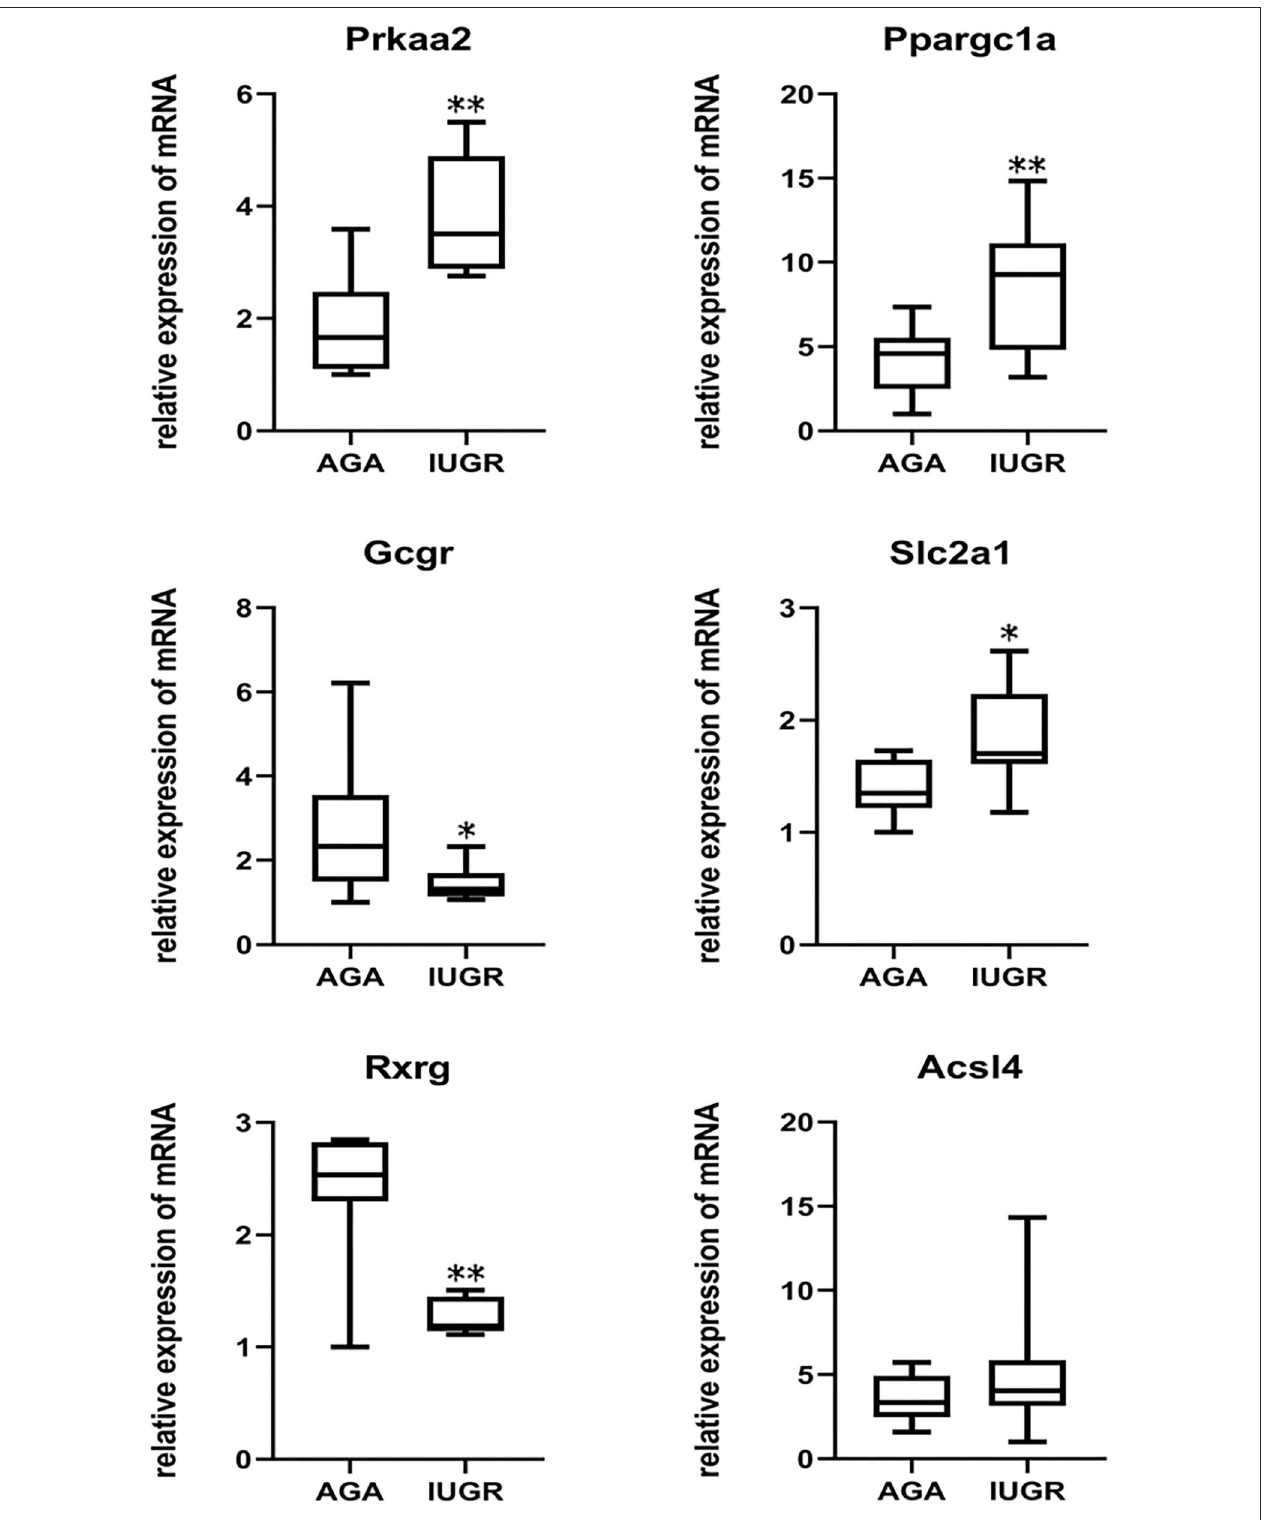
FIGURE 7 | Validation of DEGs by RT-qPCR analysis. β -actin as an internal control. Prkaa2 (IUGR: 3.81 ± 0.97; AGA: 1.86 ± 0.84) , Ppargc1a (IUGR: 8.72 ± 3.74; AGA: 4.21 ± 1.89) , Gcgr (IUGR: 1.47 ± 0.39; AGA: 2.74 ± 1.55) , Slc2a1 (IUGR: 1.84 ± 0.42;AGA: 1.38 ± 0.24) , Rxrg (IUGR: 1.26 ± 0.15; AGA: 2.39 ± 0.56) and Acsl4 (IUGR: 5.18 ± 3.75; AGA: 3.50 ± 1.33) mRNA levels were analyzed in samples of IUGR, compared with AGA. Data indicate relative expression following normalization (* P < 0.05, ** P < 0.01).